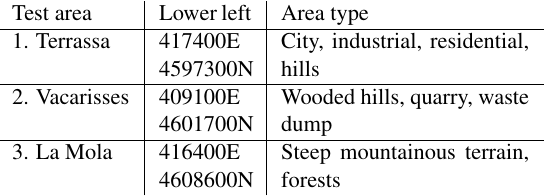
Table 1: Position and properties of the selected test areas. The